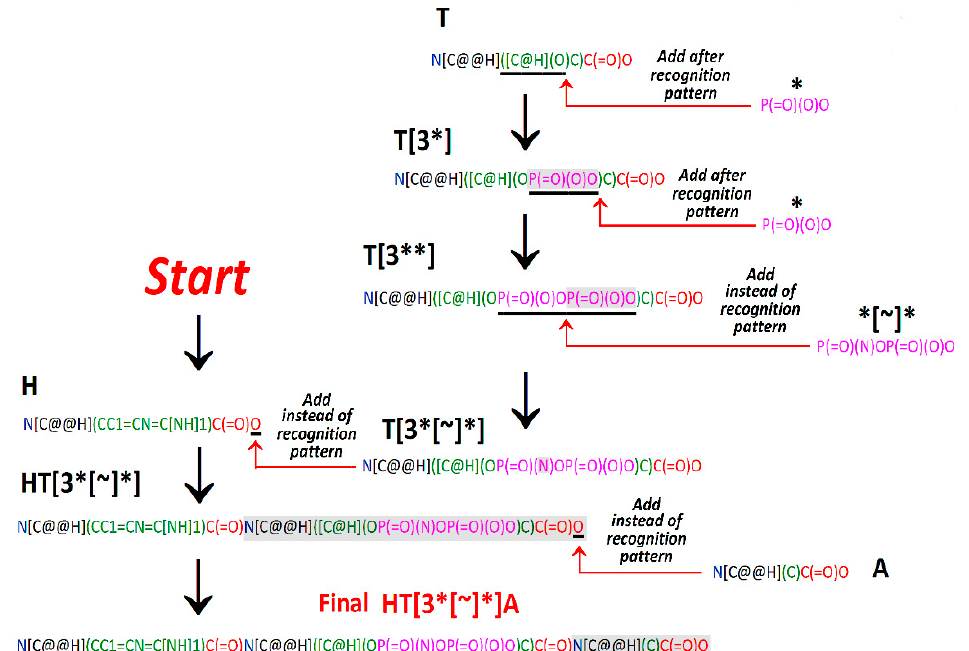
Figure 3. Construction scheme of an exemplary SMILES string of HT[3*[~]*]A—histydyl-threonyl-alanine peptide with a threonine residue modified by the addition of two phosphate groups connected via a phosphodiester bond. The phosphate group linked directly to the amino acid residue is amidated (see Table 2). Color code used in SMILES strings: α -amine group—blue; α -carbon atom—black; side chain—green; phosphate group–pink; α -carboxyl group—red, according to the convention used by Minkiewicz et al. [65] (see Tables S1–S3 in the Supplementary Materials). Recognition patterns in amino acid SMILES strings are underlined, whereas fragments added in a given step are shaded. Terms “After” and “Instead of” mean the location of a new fragment relative to the recognition pattern (see Tables S2 and S3 in the Supplementary Materials). Modification sites are indicated by red arrows.